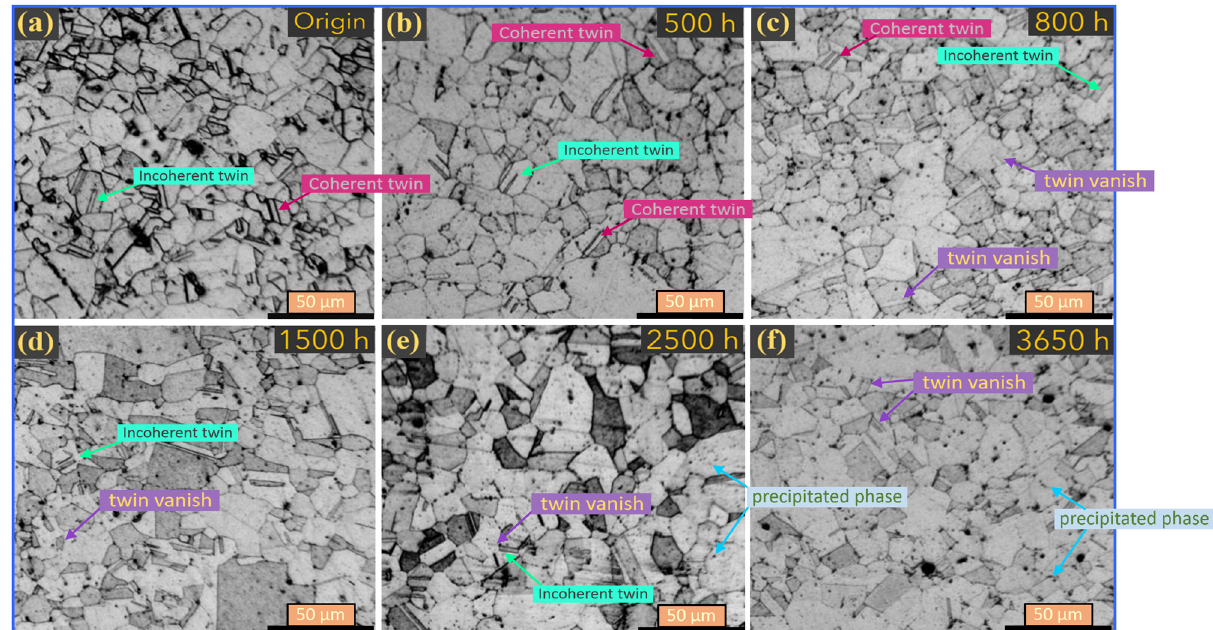
Figure 2: The microstructure observations of TP347HFG steels during the thermal aging: ( a ) origin, ( b ) 500 h, ( c ) 800 h, ( d ) 1,500 h, ( e ) 2,500 h, and ( f ) 3,650